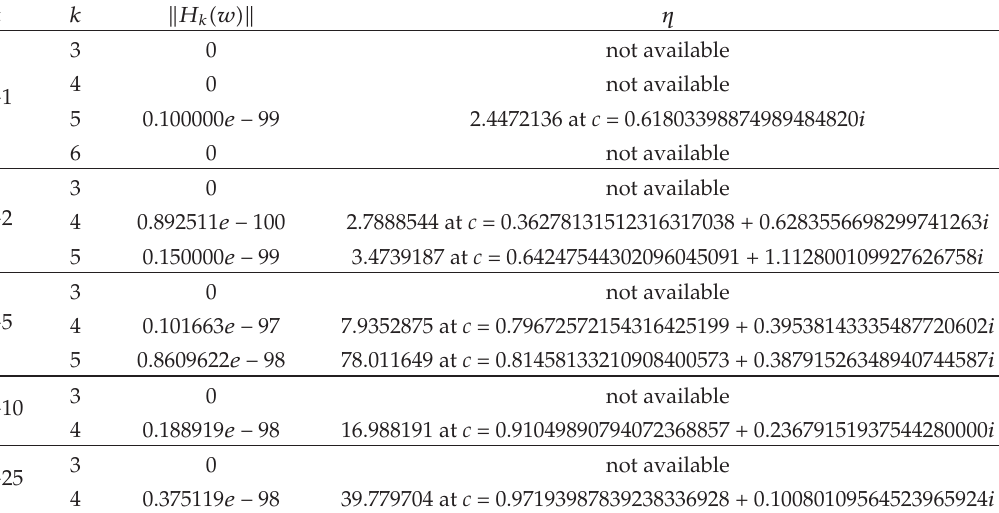
Table 3: Residual errors and asymptotic error constant for α (cid:3) − 1 , − 2 − 5 , − 10 , −